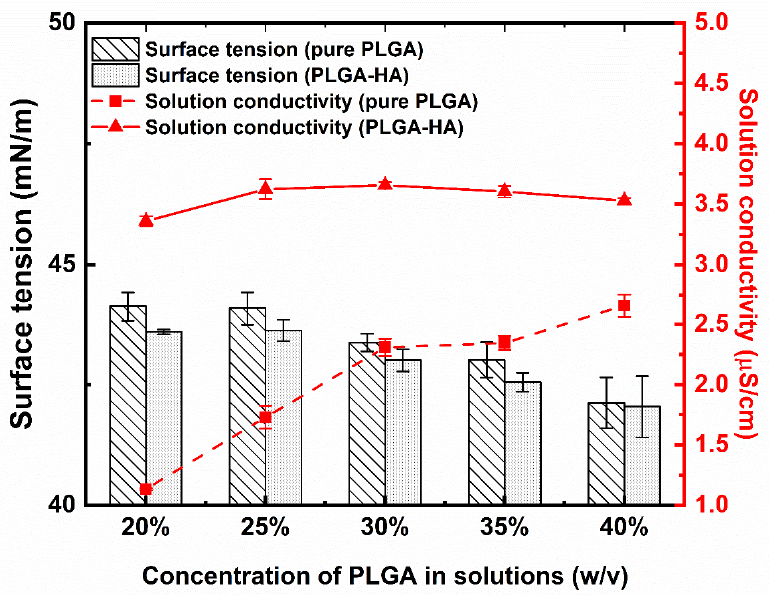
Figure 5. Solution properties of PLGA in DMSO and PLGA-1.5% HA in DMSO solutions. n = 5.